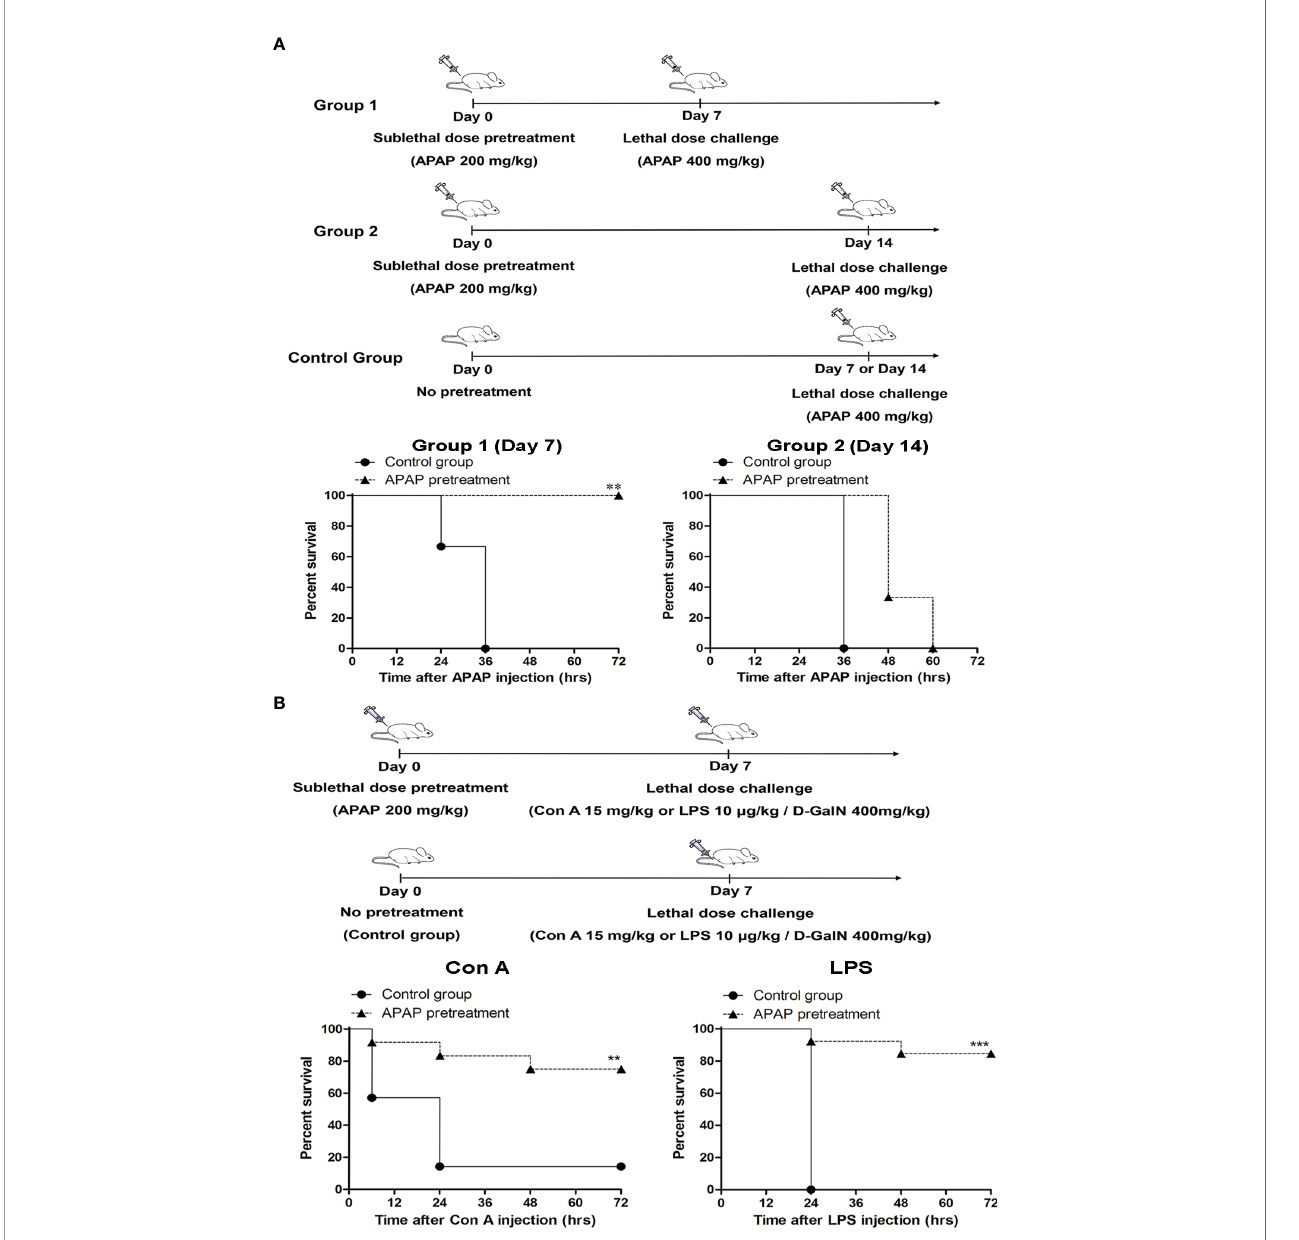
FIGURE 2 | Pretreatment with a sublethal dose of APAP protects mice from subsequent lethal challenge of acetaminophen (APAP), Con A, or lipopolysaccharide (LPS). (A) Mice (n=6 per group) were treated with a sublethal dose of APAP (200 mg/kg) on day 0. 7 days (Group 1) or 14 days (Group 2) after, mice were challenged with a lethal dose of APAP (400 mg/kg) respectively. The survival curves were plotted. (B) Mice were treated with a sublethal dose of APAP (200 mg/kg) on day 0. 7 days after, mice were challenged either with Con A or LPS/D-GalN (n=12 per group). The survival curves were plotted. The control groups were mice without APAP pretreatment, but received the lethal dose challenge. **P < 0.01, ***P < 0.001, Log-rank